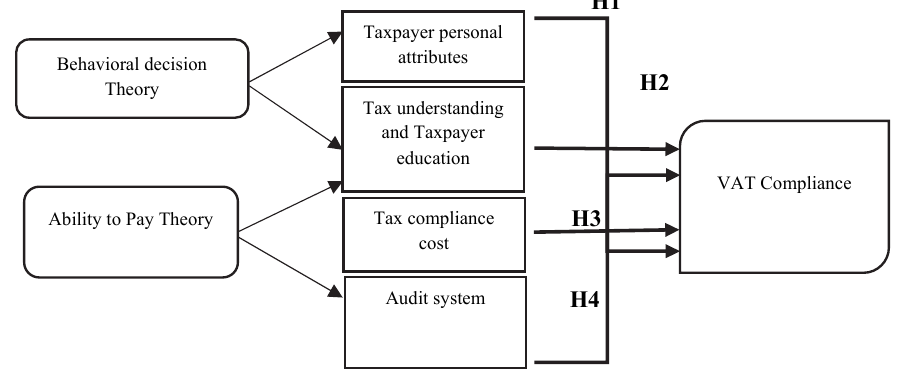
Fig. 4. The proposed study (KING’OINA,